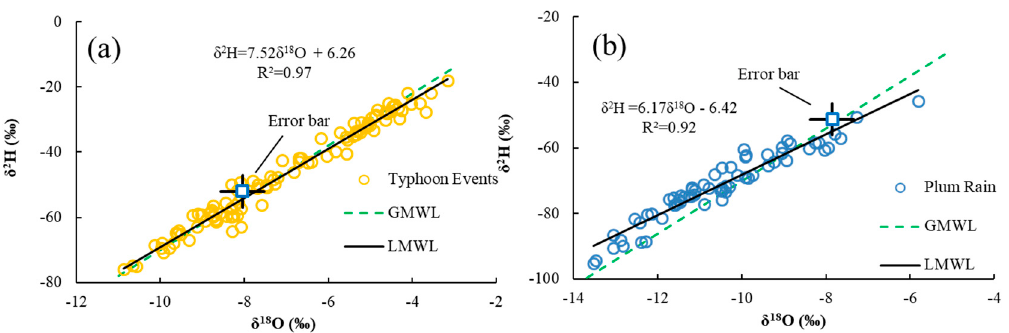
Figure 4. The relationship between δ 2 H and δ 18 O for different types of rainfall (square means the isotopic value of Nanjing station precipitation with error bars). The meteoric water line of typhoon events is in figure ( a ) with a regression equation: δ 2 H = 7.52(±0.13) × δ 18 O + 6.26(±0.91) (n = 104, R 2 = 0.97); the meteoric water line of plum rainfall event is in figure ( b ) with a regression equation: δ 2 H = 6.17(±0.23) × δ 18 O − 6.42(±2.46) (n = 66, R 2 = 0.94). The dashed lines of the two figures are the global meteoric water line to compare with the relationship between δ 2 H and δ 18 O.